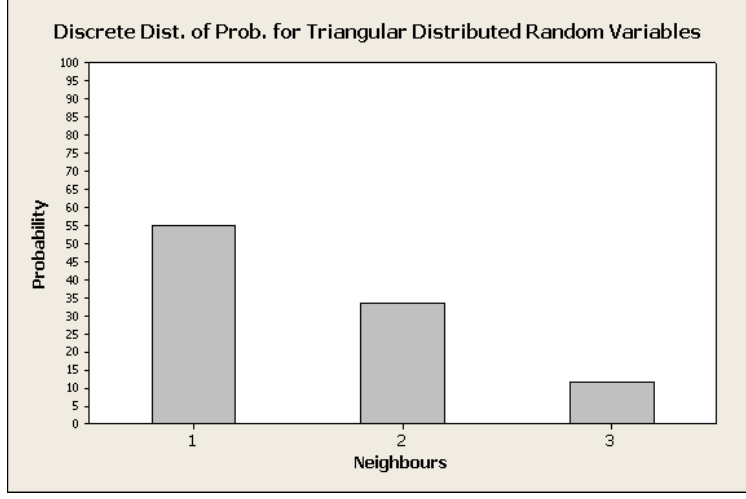
Figure 2. Discrete Probability Function for Triangular Distribution. For 3 neighbours the probabilities are distributed following the Probability Density Function of the